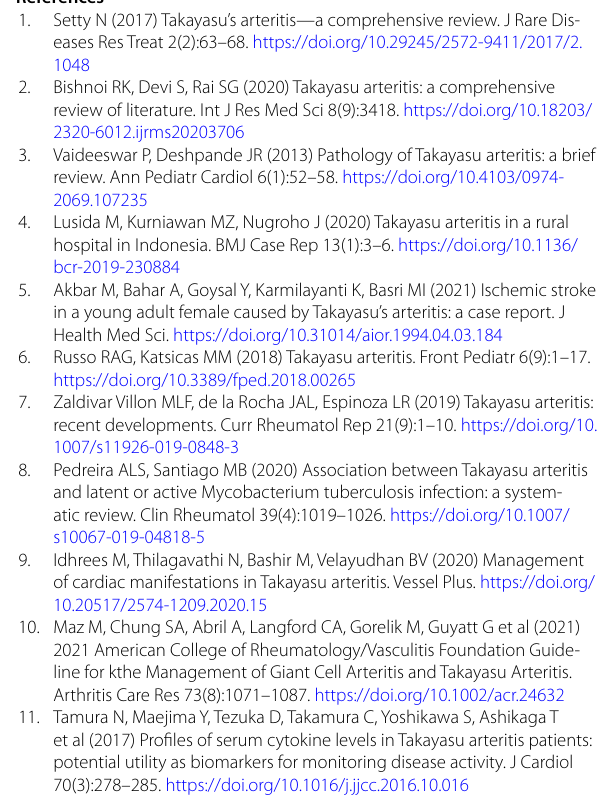
figure. SS and ADS wrote and drafted the manuscript. All authors have read and approved the final